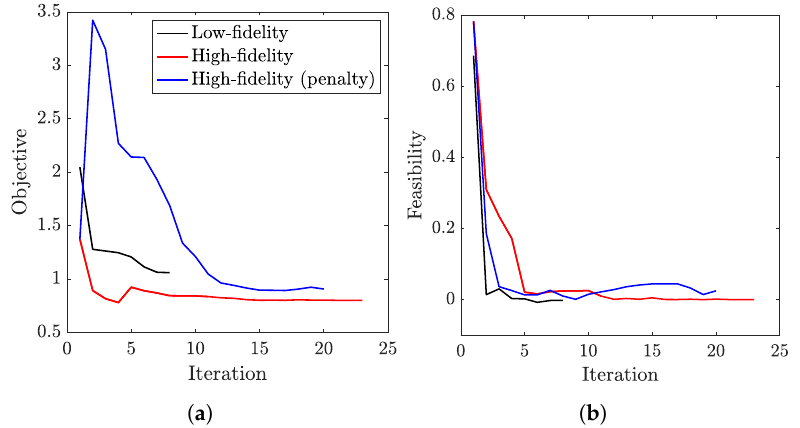
Figure 9. Convergence histories of aeroelastic problem P1a using SLSQP. ( a ) Objective; ( b ) Feasibility.